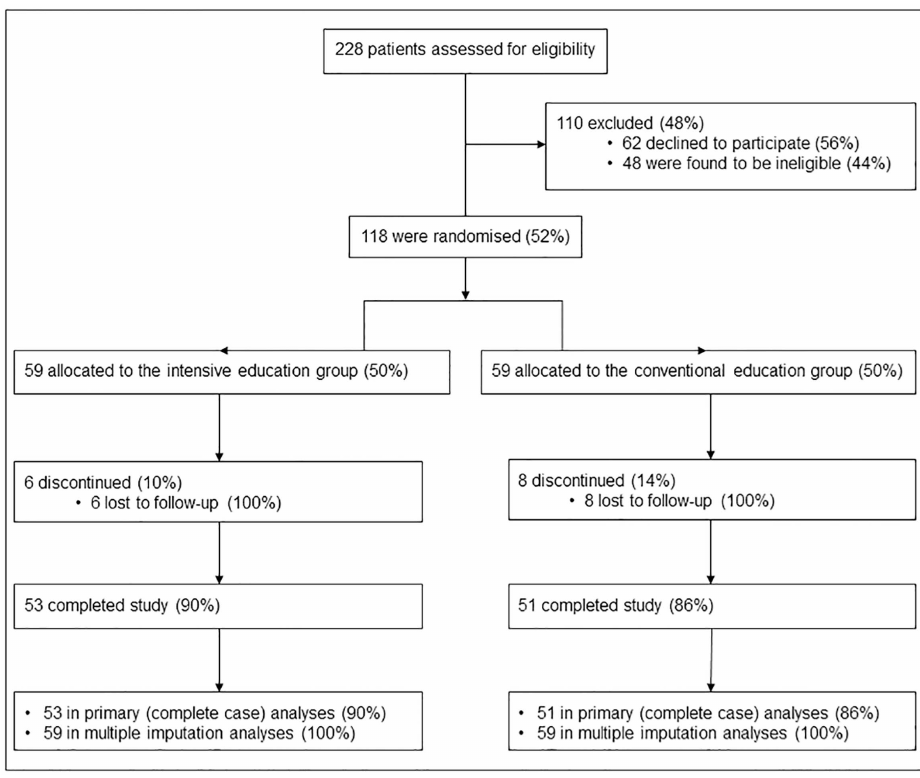
Fig 1. CONSORT recruitment and trial participant